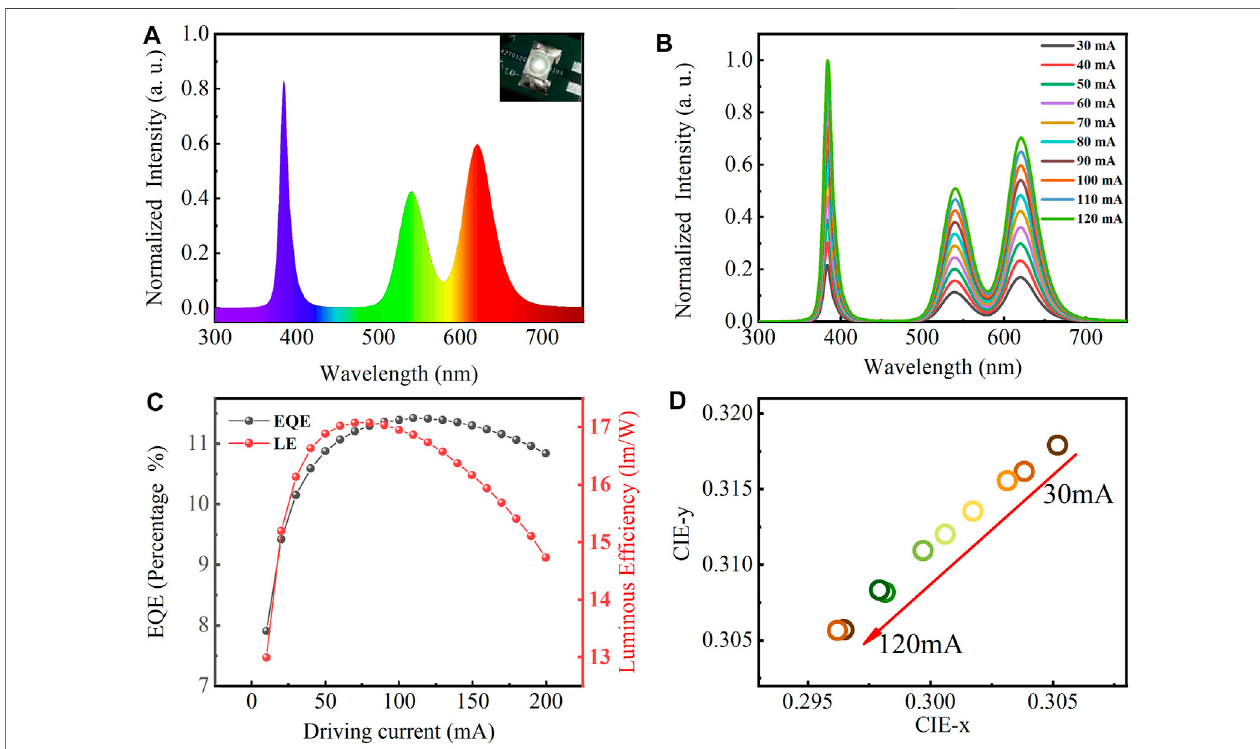
FIGURE 5 | (A) Emission spectra of QD LED device driven at 120 mA. (B) Emission spectra of QD WLED under different forward currents and driving current- dependent variations in (C) EQE and LE and (D) CIE. QD, quantum dot; LED, light-emitting diode; WLED, white light-emitting diode; EQE, external quantum ef fi ciency; LE, luminous ef fi ciency; CIE, Commission Internationale de l ’